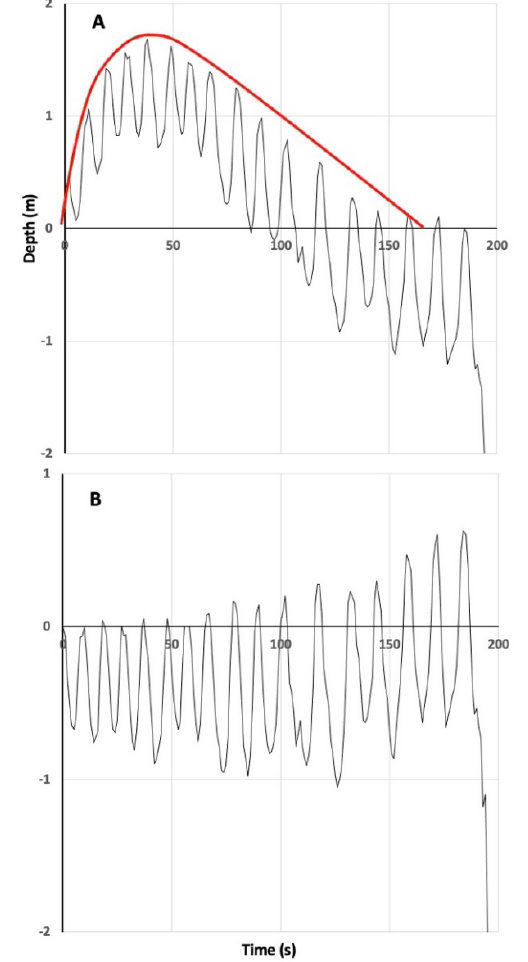
Figure 1: A: Example of a surface event where the inertia of the pressure transducer overshoots the zero m detection of the surface. B: The same event after compensation of the surface detection has been implemented. From Acousonde TM on Asgeir August 2018.